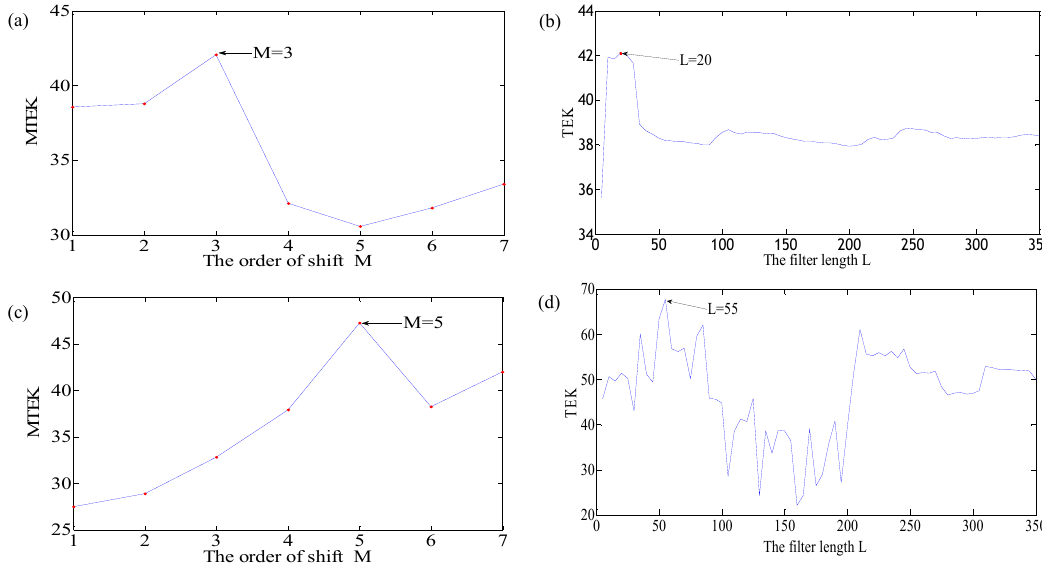
Figure 9. The variation curves of MTEK and TEK for case 1: ( a ) T o = 248, the tendency of MTEK with M; ( b ) T o = 248, the iterative result between L and TEK; ( c ) T i = 51, the tendency of MTEK with M; ( d ) T i = 51, the iterative result between L and TEK.